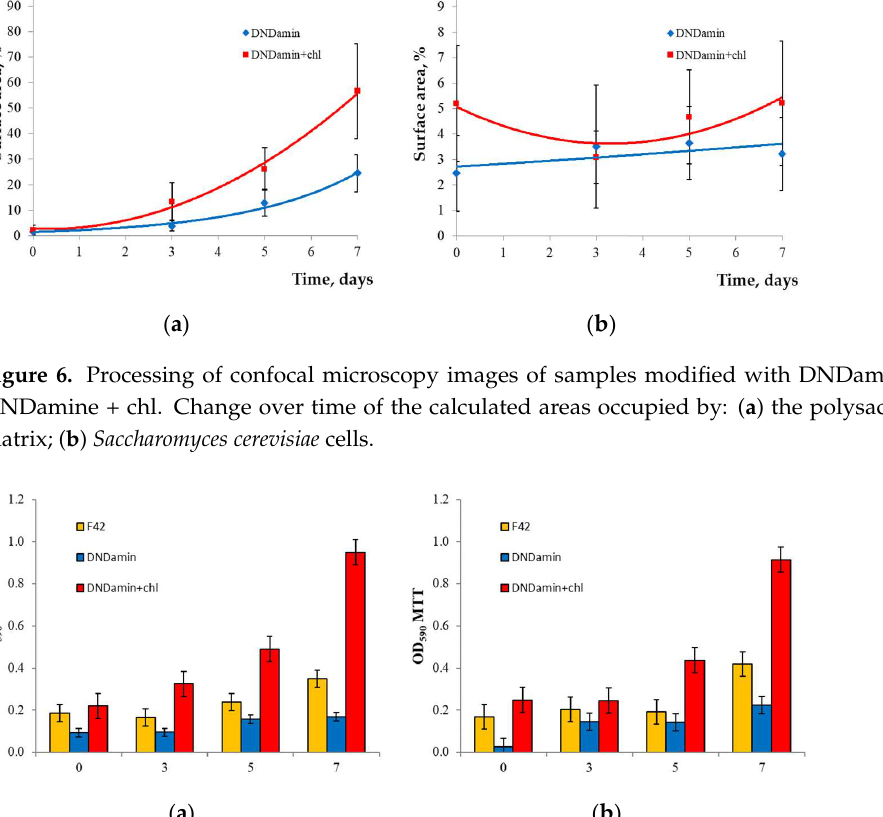
Figure 6. Processing of confocal microscopy images of samples modified with DNDamine and DNDamine + chl. Change over time of the calculated areas occupied by: ( a ) the polysaccharide ma- trix; ( b ) Saccharomyces cerevisiae cells.